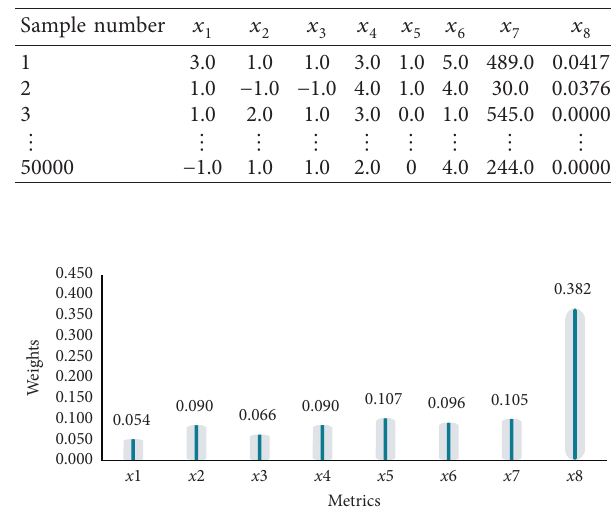
Table 2: Evaluation data.